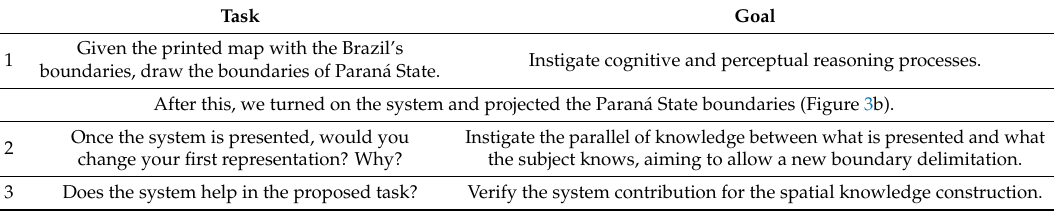
Table 2. First Stage